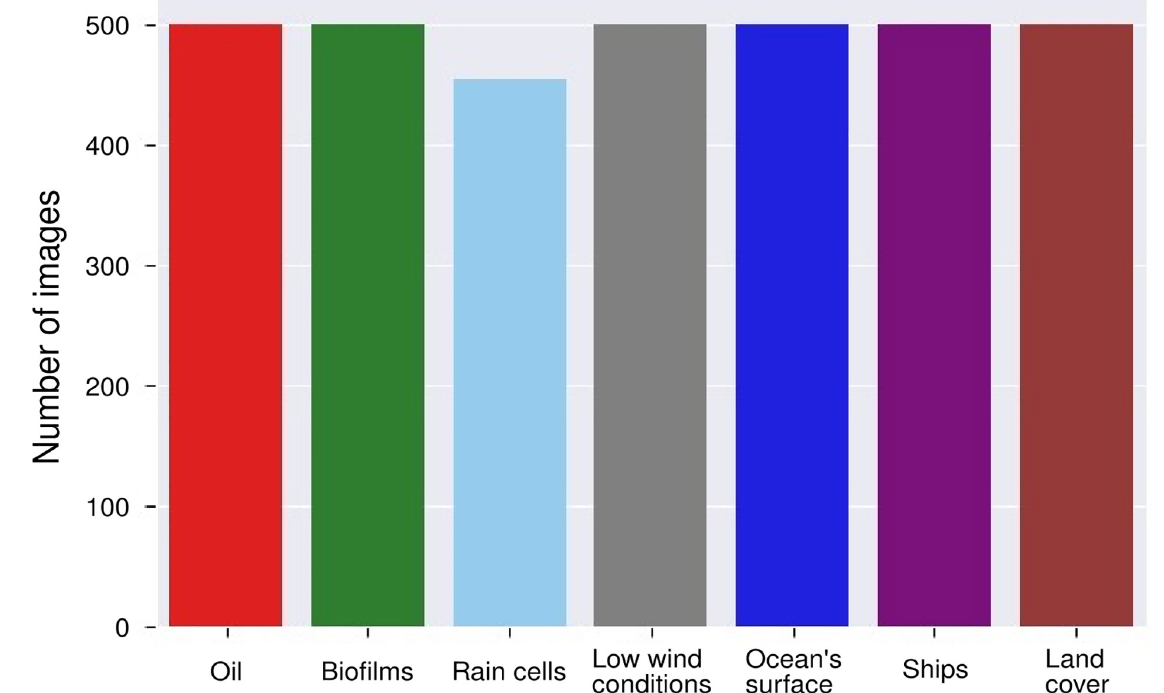
Figure 2. Number of block images in the augmented dataset used to estimate the probability density functions (PDFs) for the seven selected target